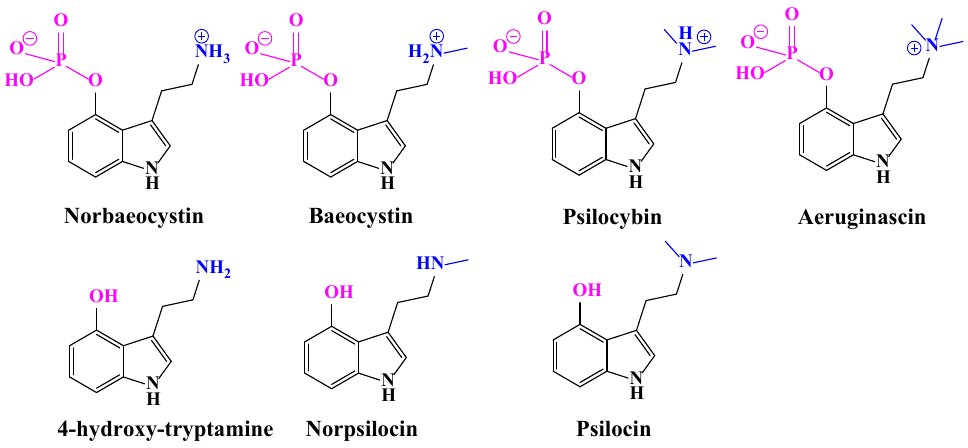
Figure 1. Tryptamines present in genus Psilocybe mushrooms.